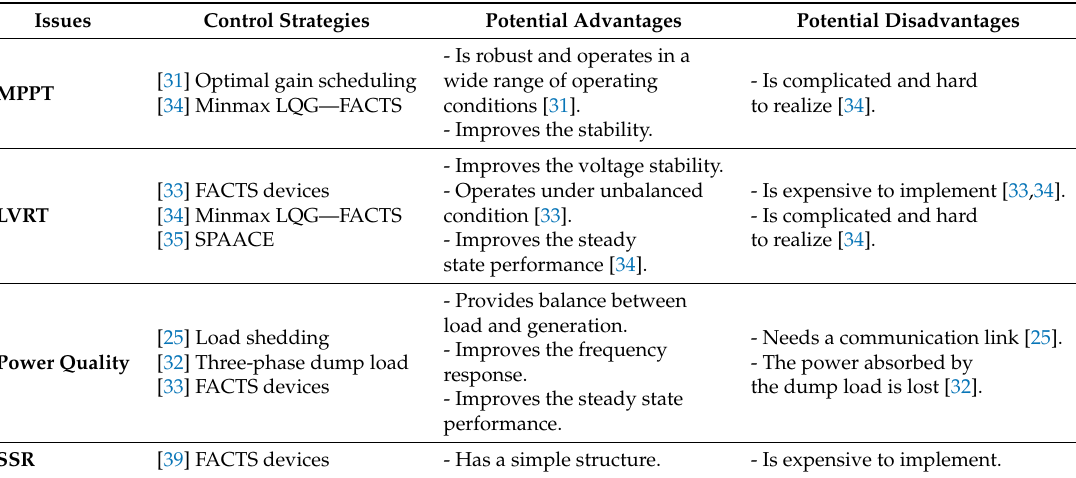
Table 1. Supplementary controllers for Type I wind turbines.